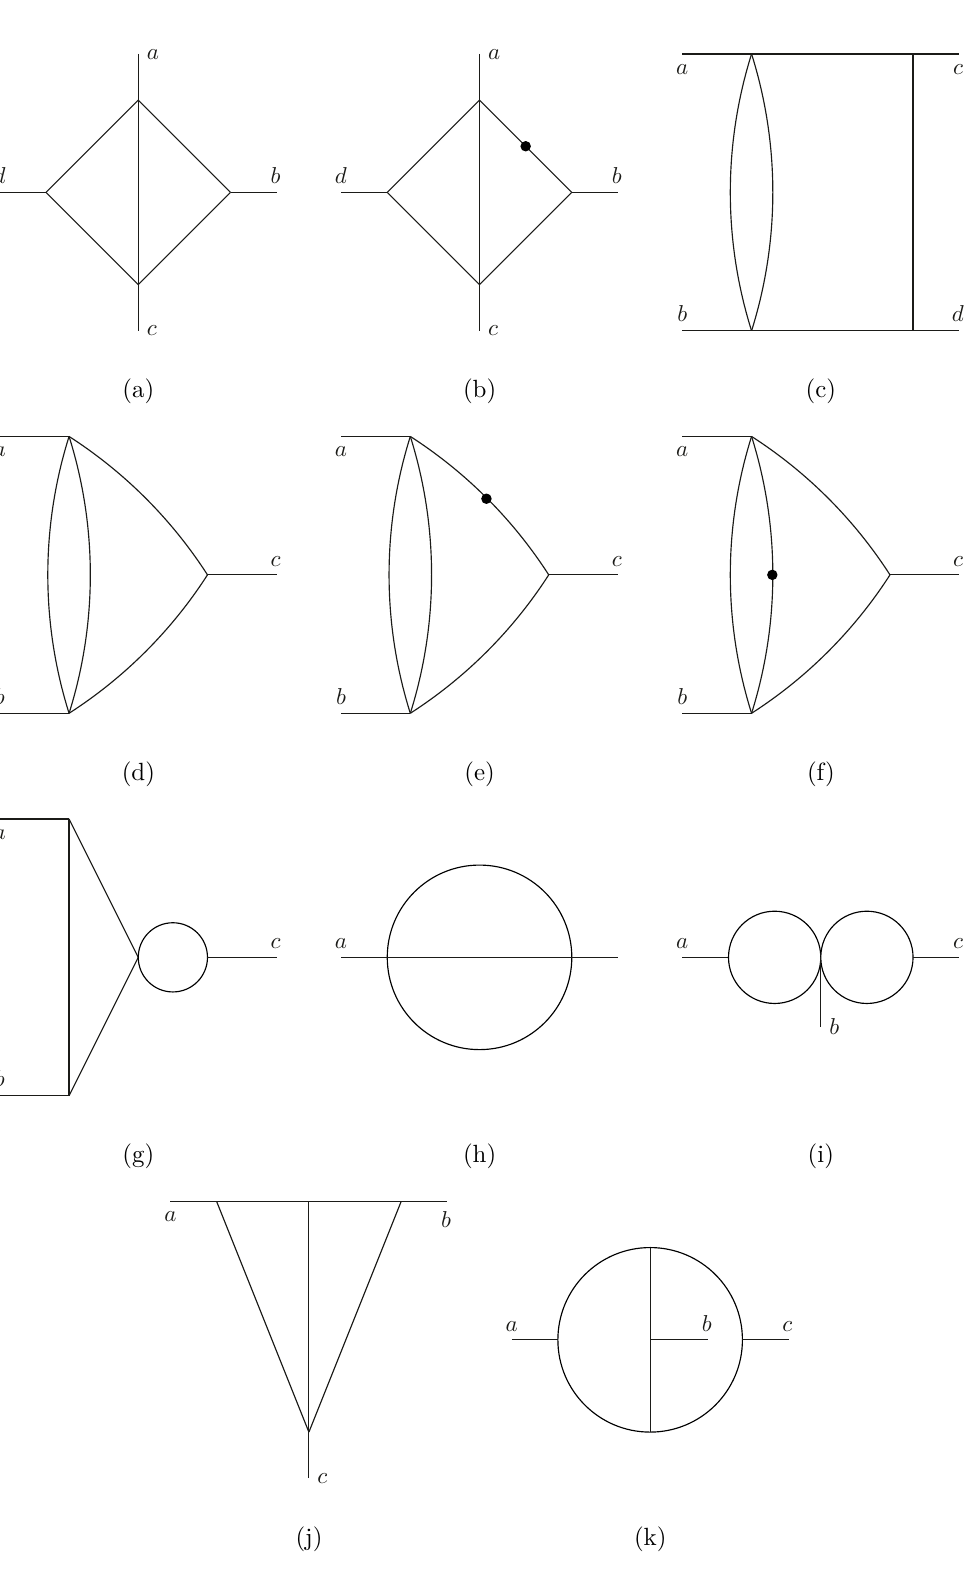
Figure 3. The topologies for all master integrals. All external momenta are incoming. A black dot represents a power of 2 on the scalar